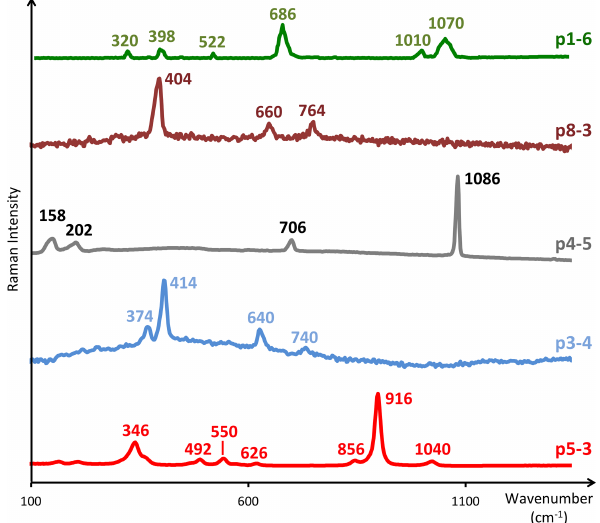
Figure 3. Raman spectra of gemstones from the Crown of Namur: emerald (p1-6), spinel (p8-3), pearl (p4-5), sapphire (p3-4), and al- mandine